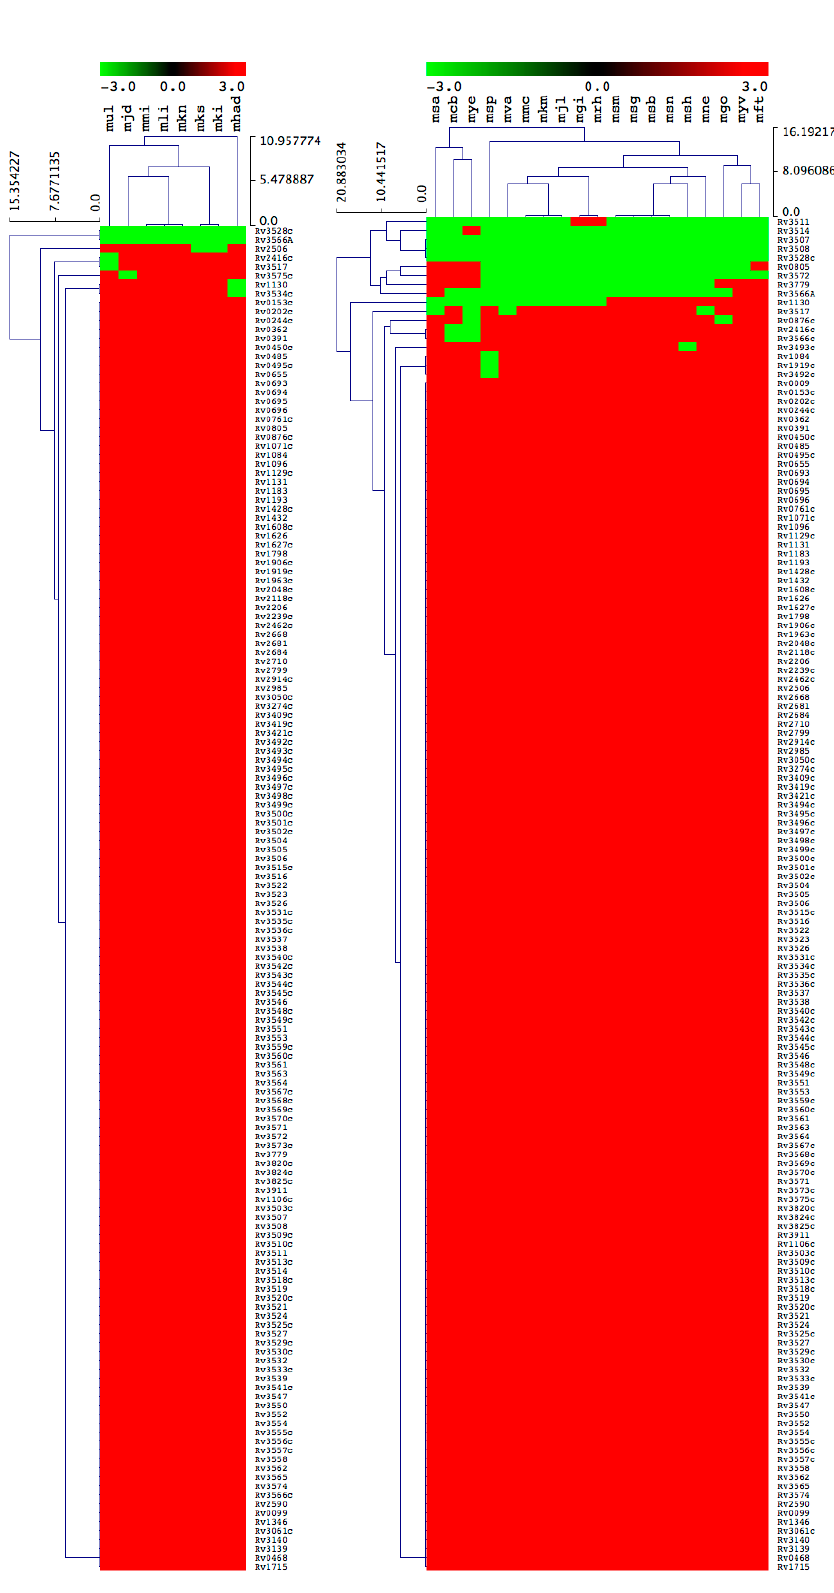
Figure 6. Heatmap of presence or absence of 151 cholesterol catabolic genes/proteins in 8 non-tuberculosis Mycobacterium species (left panel) and 19 SAP (right panel). The data have been represented as –3 for gene absence (green) and 3 for gene presence (red). The 8 and 19 mycobacterial species are represented on the horizontal axes (see Table 3 for species codes) with the 151 genes/proteins on the vertical axes.